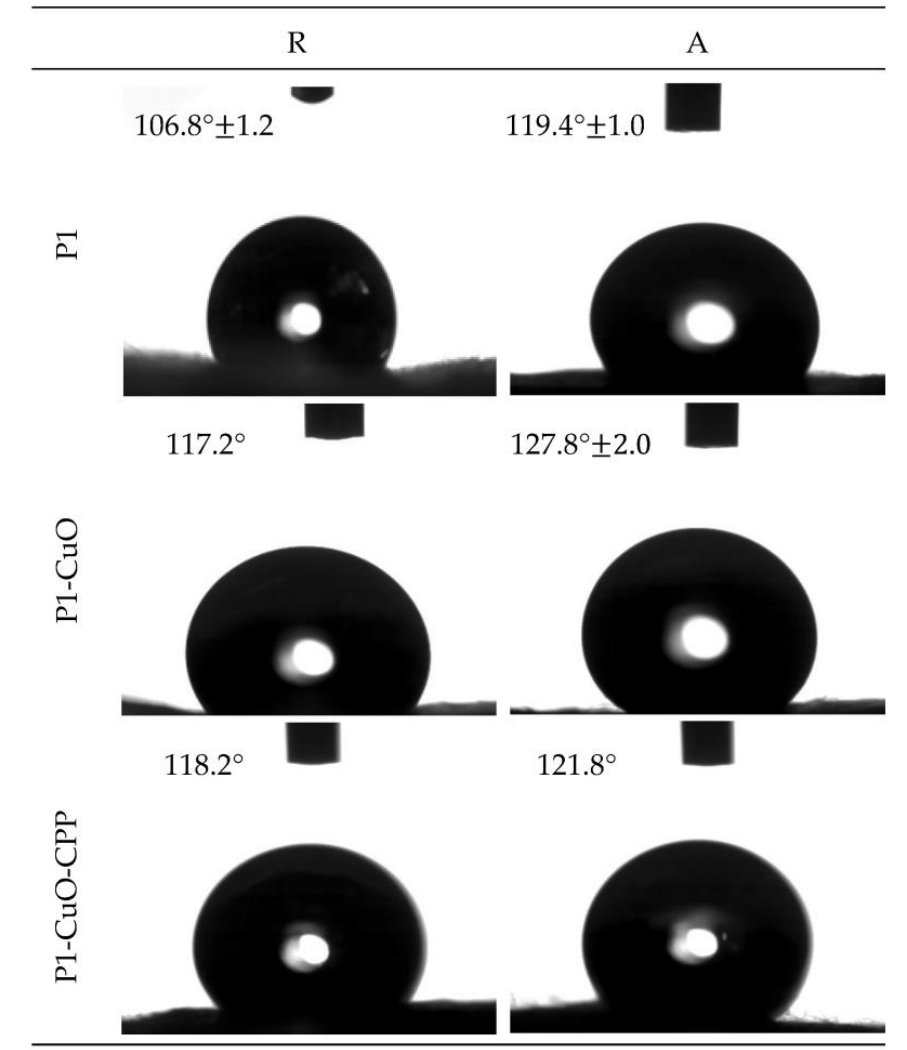
Figure 4. Images of the buffer drop onto the surface of P1, P1-CuO, and P1-CuO-CPP random (R) and aligned (A) scaffolds after 1000 ms. In each image, the value of the contact angle is reported (mean values ± SD, n = 4) (needle diameter: 0.405 mm). One-way ANOVA, Scheffé test ( p ≤ 0.05) is reported in the Supplementary Information (SI: Section S1.3.1).